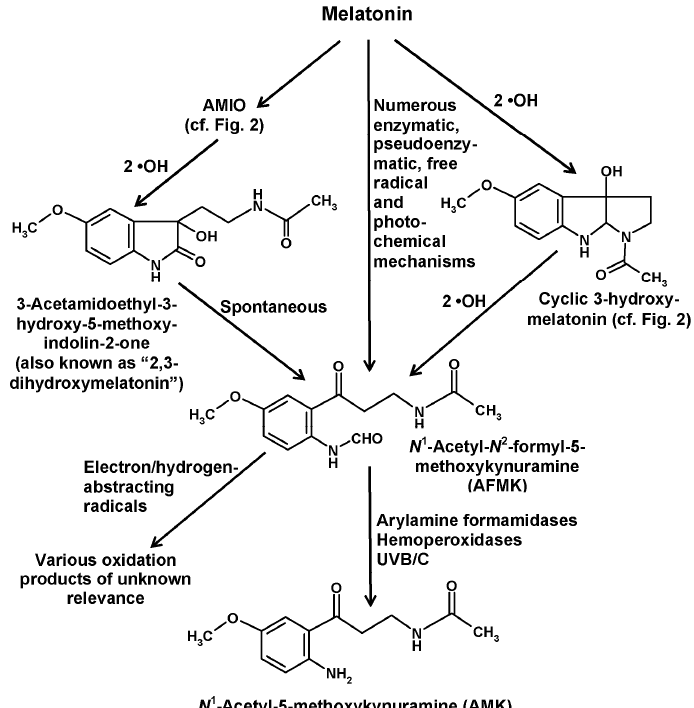
Figure 4. Formation of the kynuric metabolites AFMK and AMK from melatonin. Abbreviation: AMIO, 3-acetamidoethyl-5-methoxyindolin-2-one. For further details of reactions leading to AFMK formation from melatonin see References [29,89,90]. Products from oxidation of AFMK by electron/hydrogen-abstracting radicals have been characterized in Reference [121].